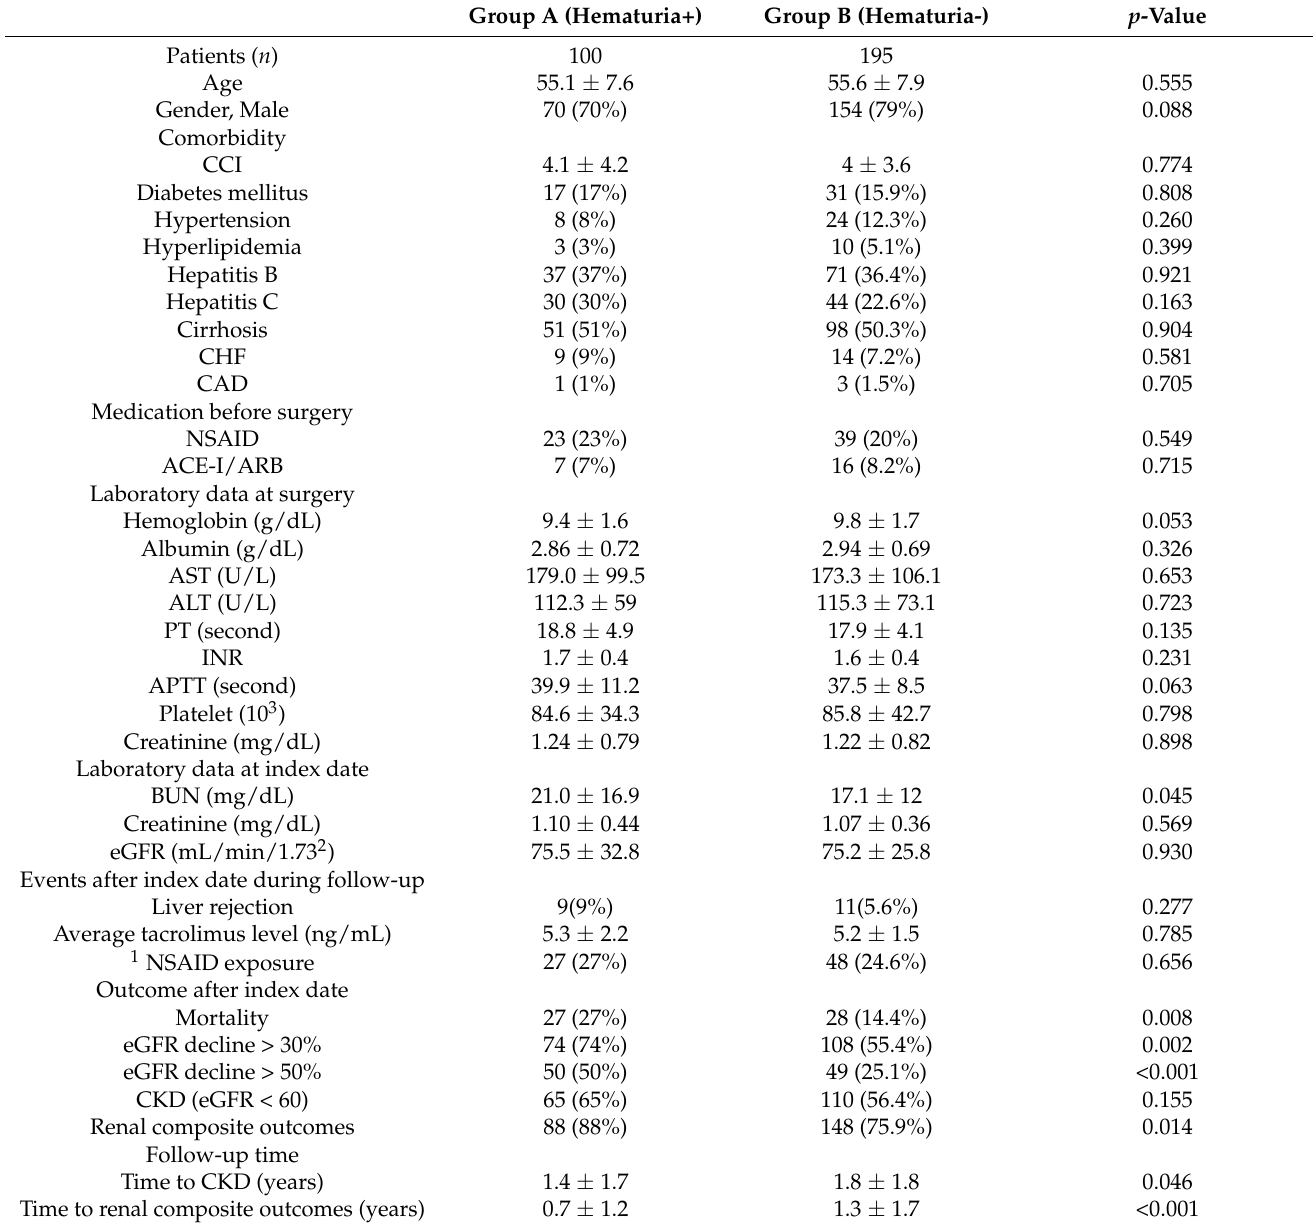
Table 1. Demographic